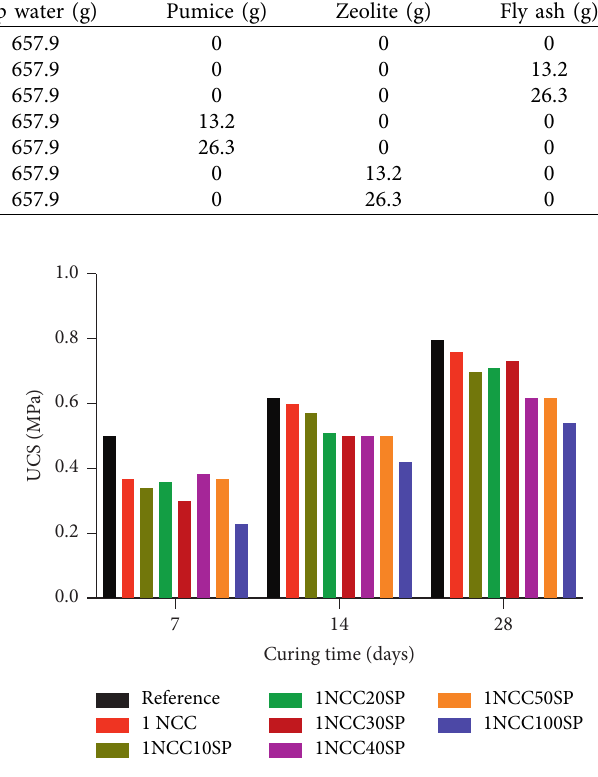
Figure 3: Mean unconfined compressive strength (UCS) for triplicate backfill samples prepared with 1% nano-calcium car- bonate (NCC) and 0–100% superplasticizer (SP). See Table 5, for mixture